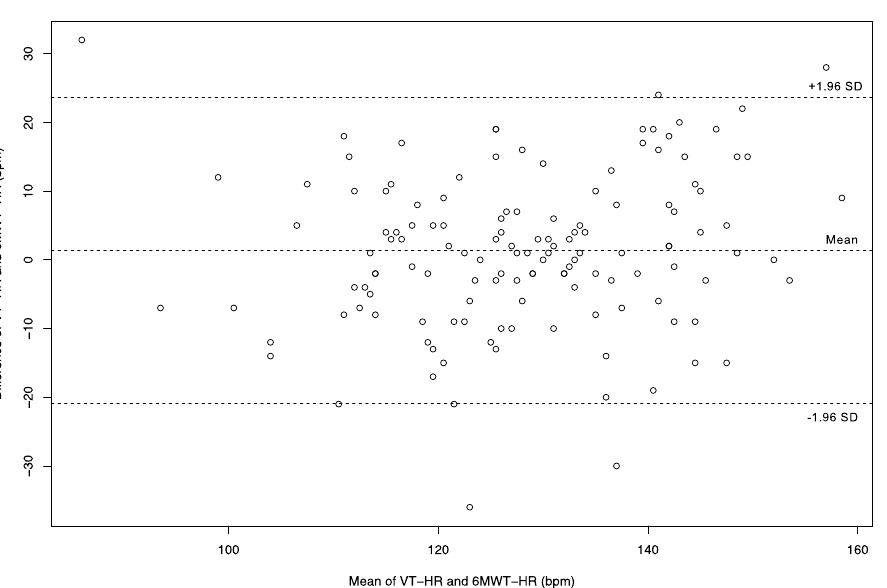
Figure 2. The extent of agreement between the 6MWT-HR and VT-HR at baseline (Bland–Altman plot).